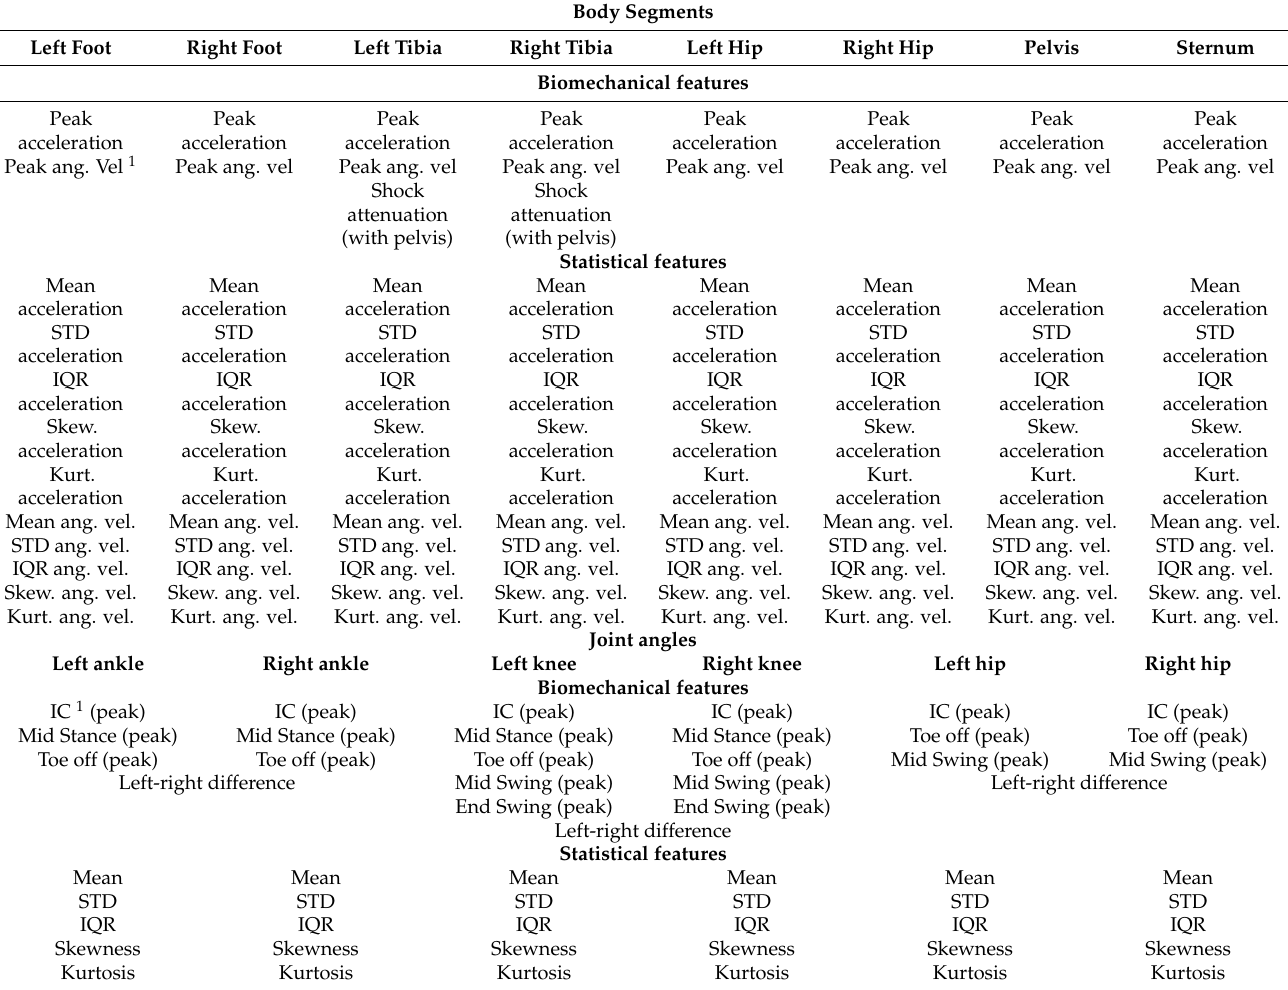
Table 2. Features extracted for each body location. Features were extracted from acceleration and angular velocities of eight body segments (top) and from the angles of six joints (bottom). Additionally, shock attenuations were computed between the left tibia and pelvis, and between the right tibia and